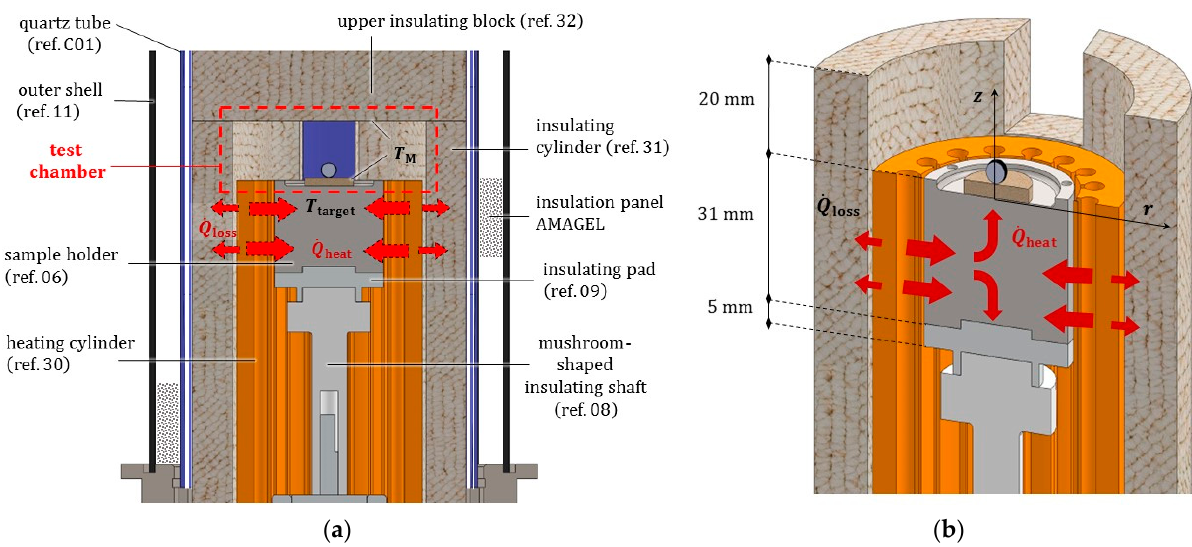
Figure 10. ( a ) Longitudinal radial section of the furnace deprived of the headers. ( b ) Axonometric view of the radially sectioned heating element (ref. 30 ), the cylindrical sample holder (ref. 06 ) and the insulation layer with an opening along the X-ray beam path. A pictorial representation is provided for the heat generated by the ceramic circular crown, a part of which is transferred to the sample (ref. 06 ) whilst another part is lost.